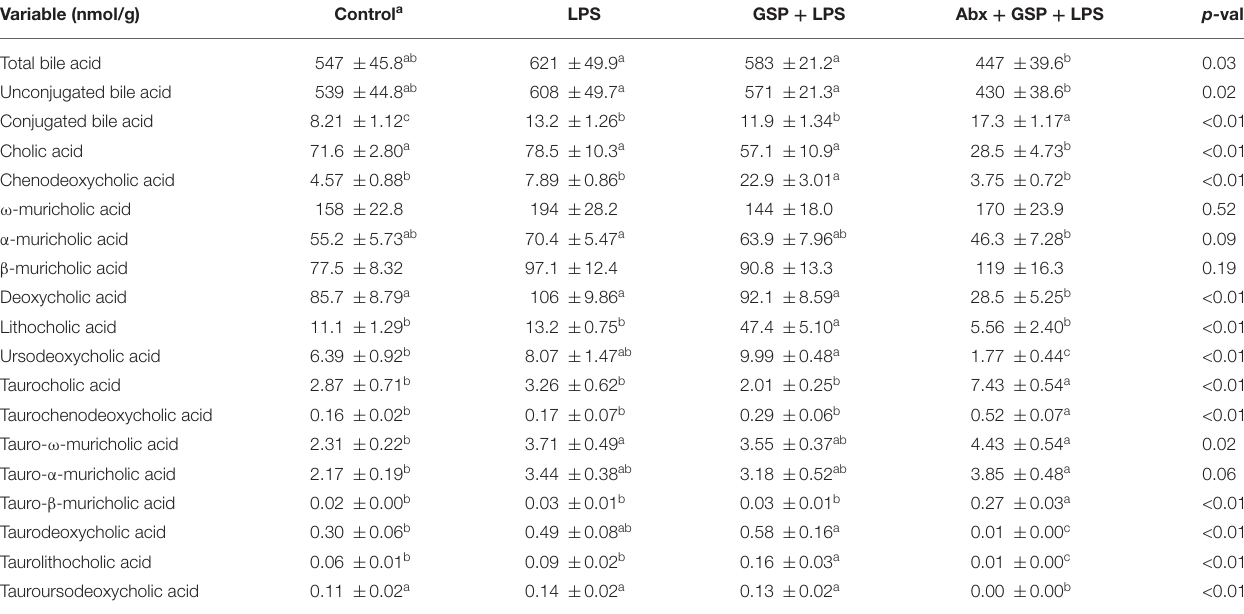
TABLE 2 | Fecal BA profiles of mice in Experiment